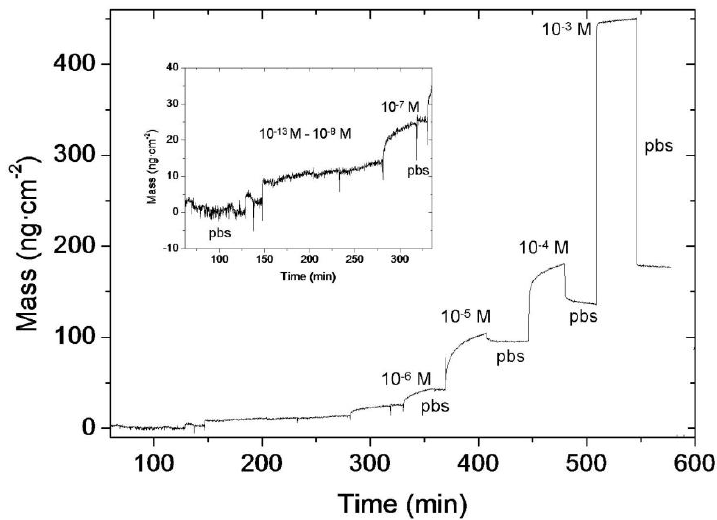
Figure 6. OWLS graphic showing the mass of HSA protein adsorbed on the Si functionalized